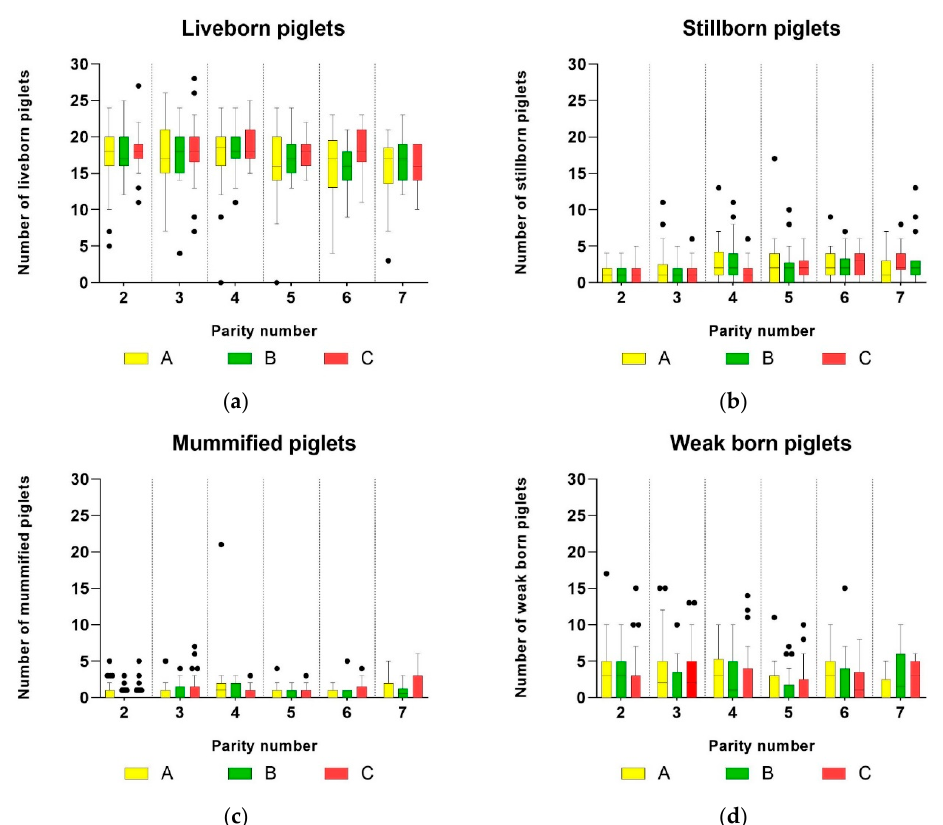
Figure 1. Comparison of number of liveborn piglets ( a ), stillborn piglets ( b ), mummified piglets ( c ) and weak-born piglets ( d ) in sows of different parity from three tested groups: A (sows vaccination 1 day after weaning), B (unvaccinated) and C (sows vaccination 28 days after weaning). The box-and-whiskers plot was constructed based on Tukey’s method. The horizontal lines show median values.